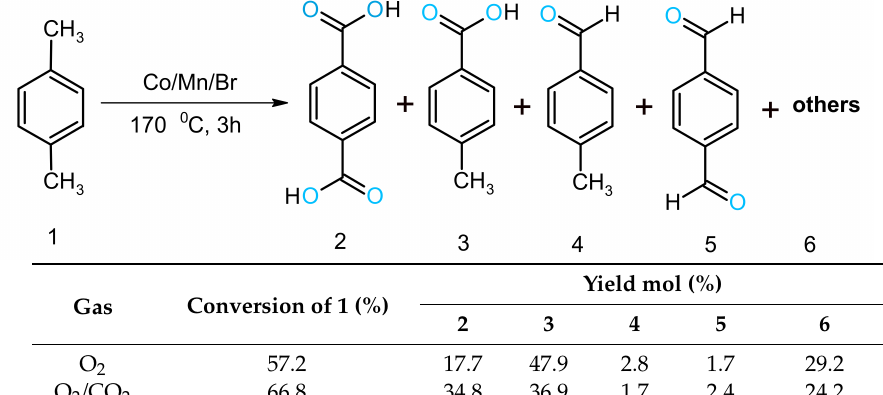
Table 3. E ff ect of CO 2 on the MC-type catalyst for oxidation of p -xylene (Reproduced from [22]; copyright (2012), Royal Society of Chemistry).